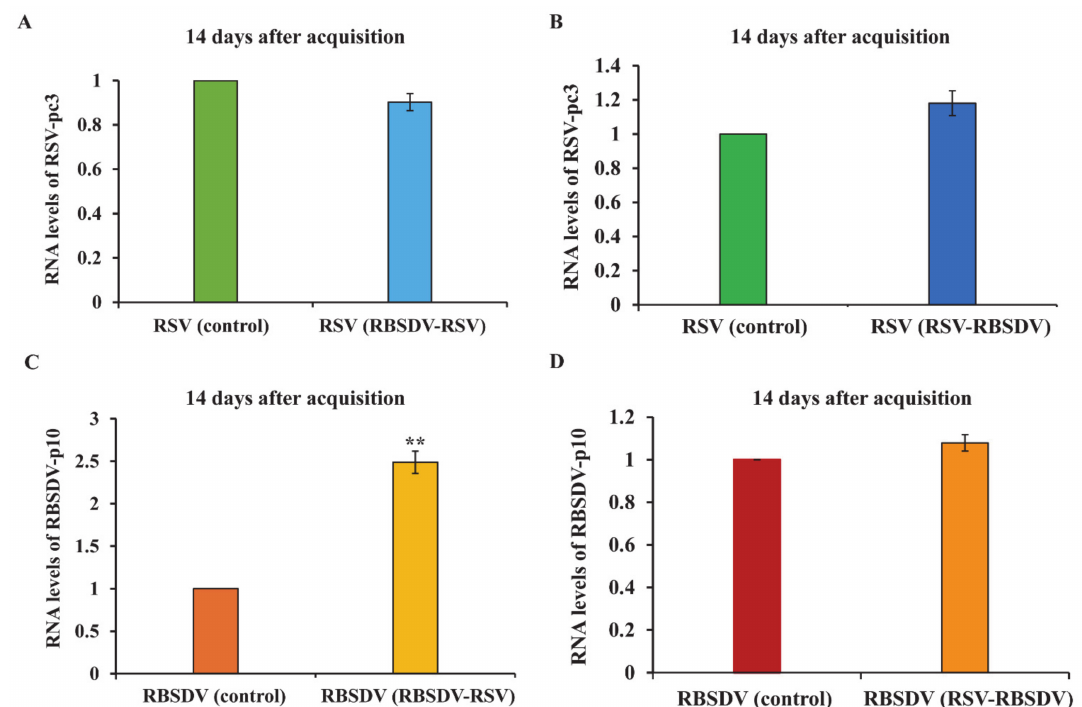
Figure 5. Relative RNA levels of RSV-pc3 and RBSDV-p10 at 14 days after acquisition access of RBSDV-RSV and RSV-RBSDV groups. RSV-pc3 relative RNA levels in RBSDV-RSV group ( A ) and RSV-RBSDV group ( B ); RBSDV-p10 relative RNA levels in RBSDV-RSV group ( C ) and RSV-RBSDV group ( D ). Three biological replicates were performed, each of which had three technical replicates. Asterisks (**) indicate a significant difference at p < 0.01 in Tukey’s HSD test with 95 % confidence.